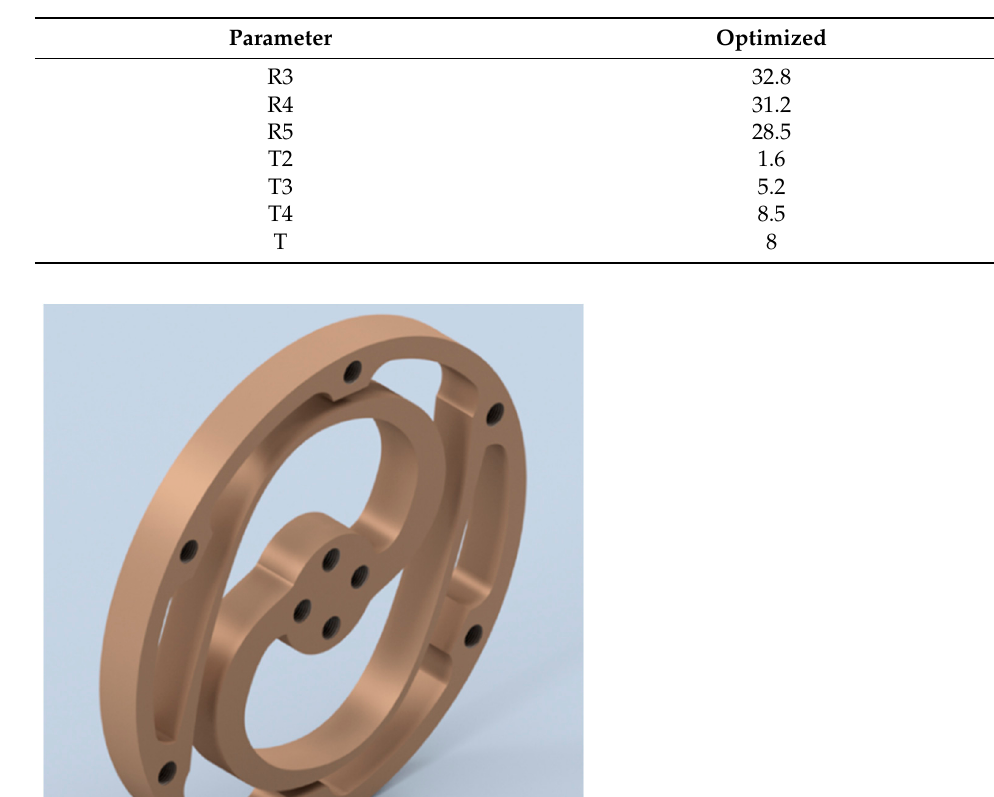
Table 5. Optimized parameters for the chosen topology.